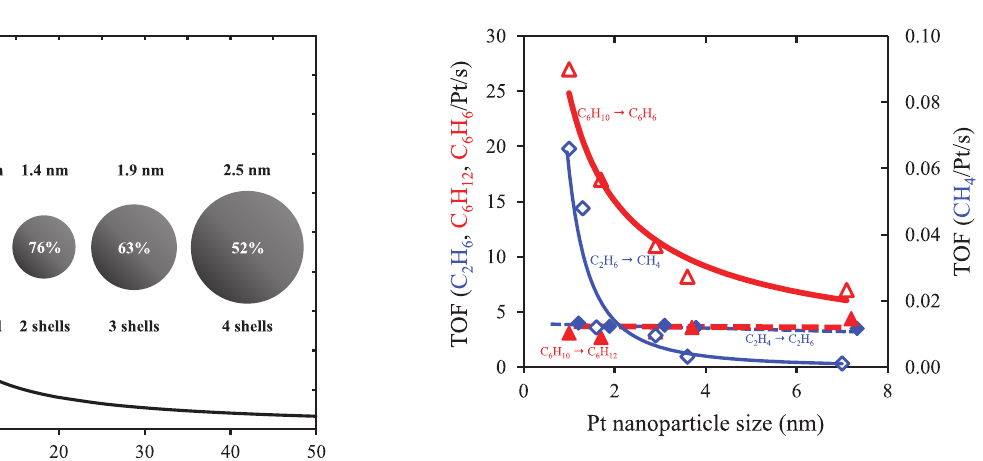
Fig. 5 TOF values for structure-insensitive Pt-catalysed reac- tions, marks indicate experimentally determined data- points (C 2 H 4 hydrogenation: blue dotted line and ◆ , C 6 H 10 hydrogenation: red dotted line and ▲ ) and structure-sensitive reactions (C 6 H 10 dehydrogenation: red solid line and △ , C 2 H 6 hydrogenolysis: blue solid line and ◇ ; plotted on secondary vertical axis) (based on Somorjai and Park